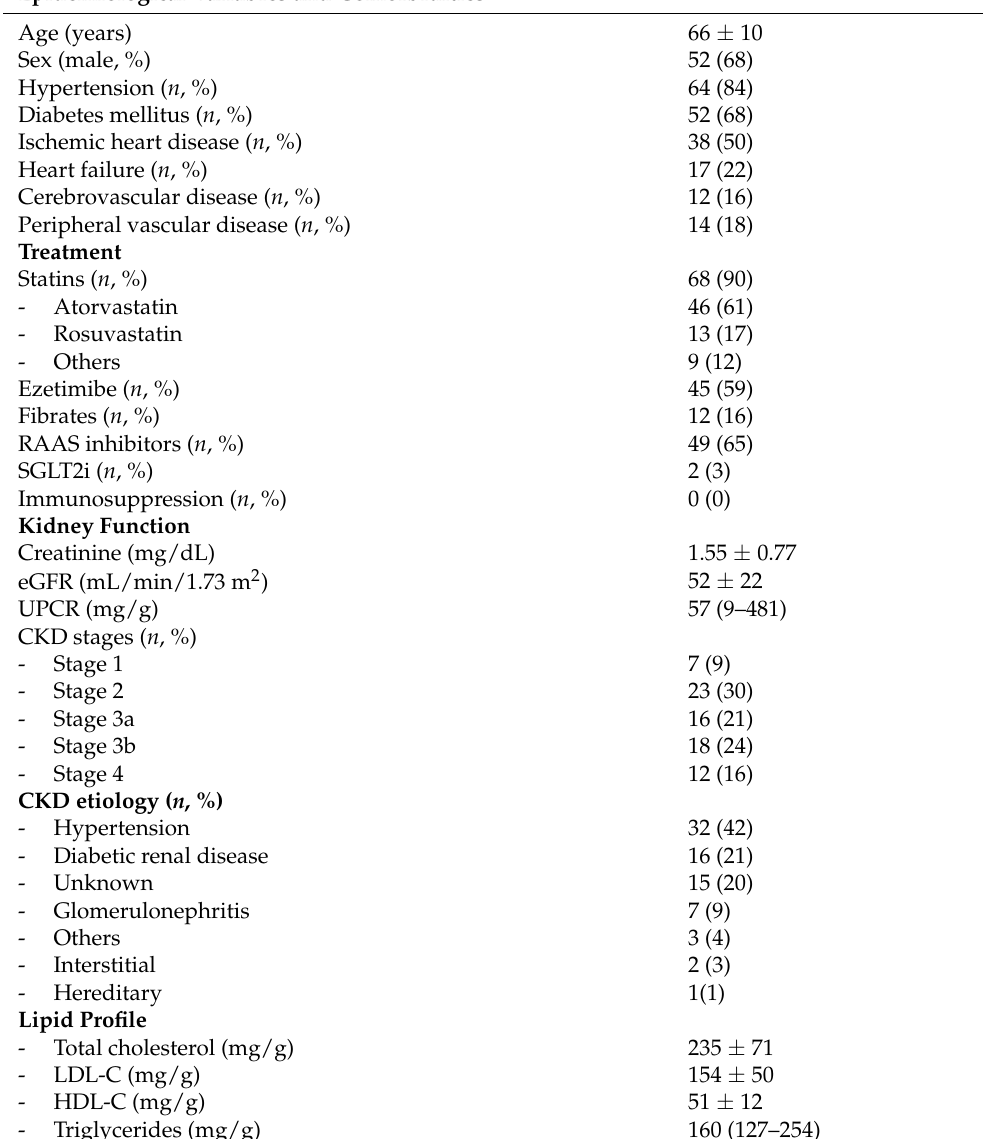
Table 1. Baseline